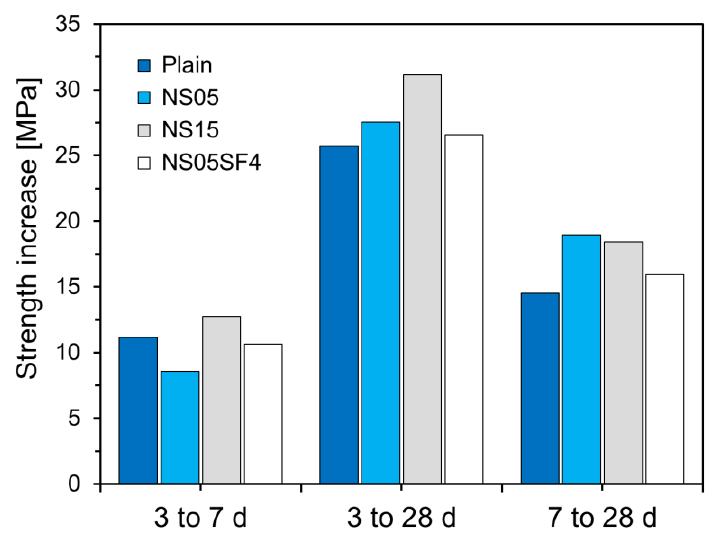
Figure 9. Increases in specimen strengths during different age intervals.